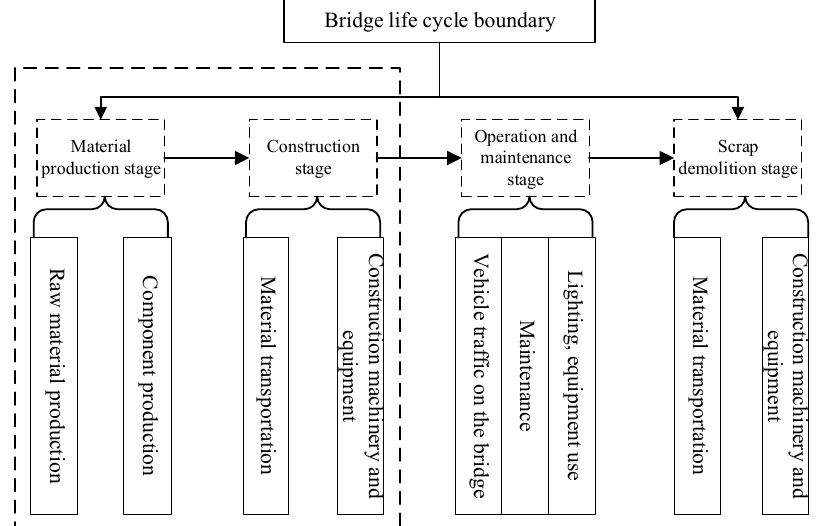
Figure 1. Calculation boundary of carbon emissions of bridges (the dashed line is the research content of this paper).